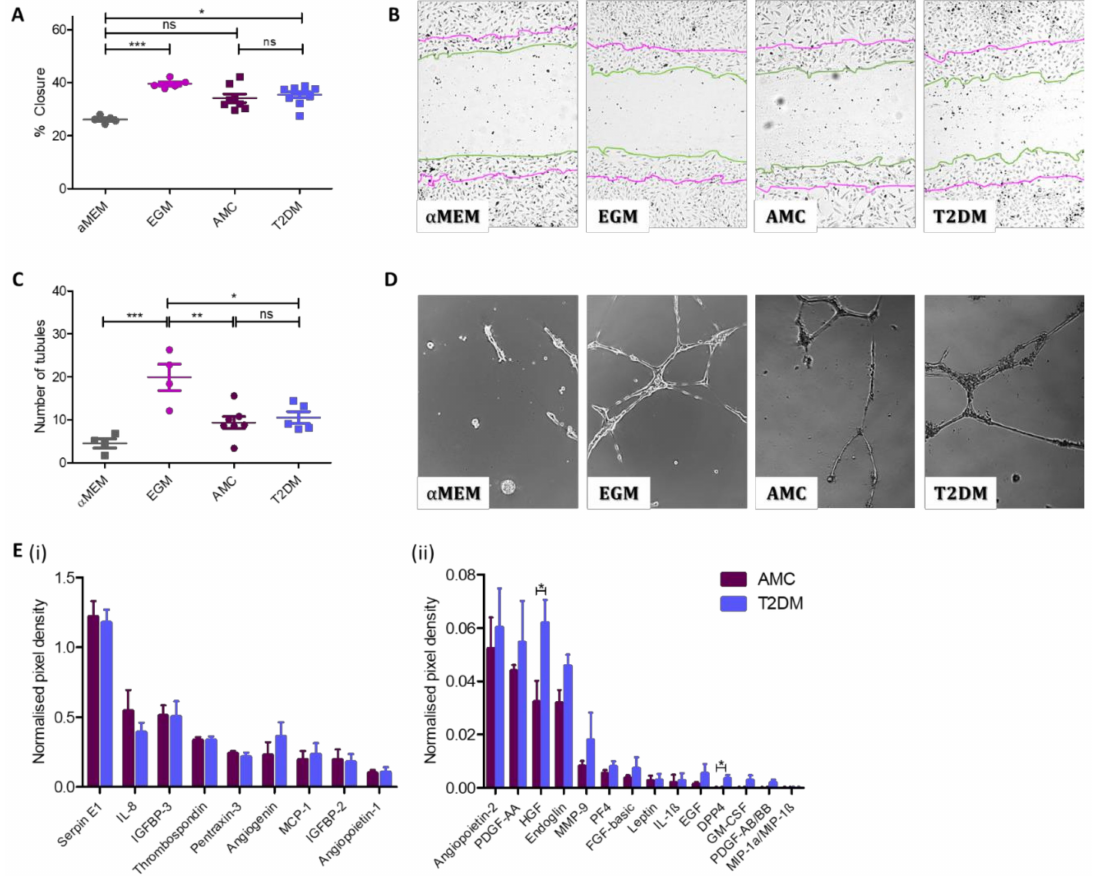
Figure 4. The presence of T2DM does not influence the capacity of MSC-secreted factors to support angiogenesis. The angiogenic capacity of MSCs to support migration of surrounding cells and to induce tubule formation was evaluated. ( A ) Quantification of HUVEC cell migration into a scratch in the HUVEC monolayer in the presence of MSC-conditioned medium indicated cells isolated from donors with ( n = 10) or without T2DM ( n = 8) were capable of stimulating HUVECs to close an in vitro wound. ( B ) Representative images display a notable decrease in the scratch width as a result of exposure to MSC-conditioned medium regardless of donor cohort. Images obtained by 10 × objective as described in methods. Zero h scratch width is overlain onto the photograph taken at 8.5 h, with the 0 h outline traced in purple and the 8.5 h line outlined in green. ( C ) MSC-conditioned medium was capable of stimulating the formation of endothelial cell tubules regardless of its donor origin (AMC n = 7 and T2DM n = 5). ( D ) Representative images indicate the presence of long, branching tubules forming complete loops with a comparable morphology in cultures exposed to both types of MSC conditioned medium. Images obtained by 10 × objective as described in methods. ( E ) Angiogenic protein levels in conditioned media at higher concentrations ( i ) and at lower concentrations ( ii ). Multiple T-test in R demonstrated increased levels of two secreted proteins (HGF and DPP4, mean ± SEM were 0.0322 ± 0.008 (AMC) and 0.0619 ± 0.009 (T2DM), and − 0.002 ± 0.001 (AMC) and 0.003 ± 0.001 (T2DM), respectively), and no significant di ff erence in levels where no statistics summary label is provided on the image ( n = 4 per cohort). All data are displayed as mean ± SEM. * = p ≤ 0.05; ** = p ≤ 0.01, *** = p ≤ 0.001, ns = not significant, i.e., p >